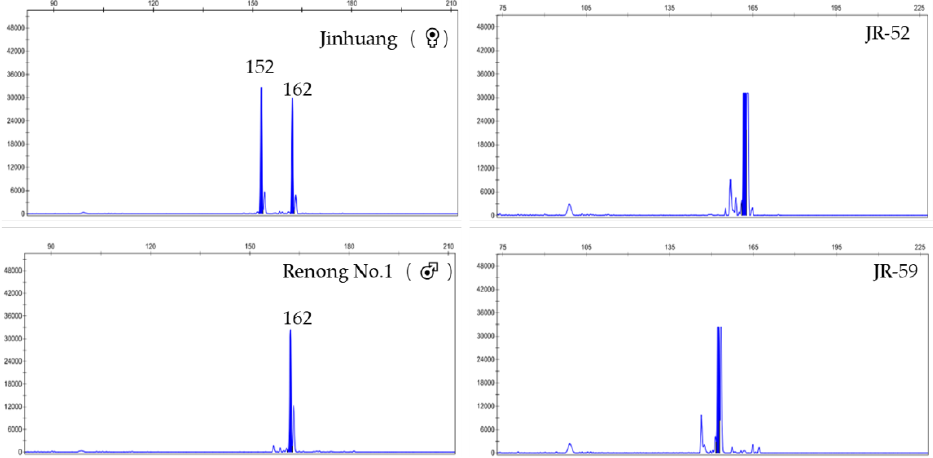
Figure 1. Capillary electrophoresis results obtained with ES39 for ‘Jinhuang’, ‘Renong No.1’, true hybrid JR-52, and false hybrid JR-59.